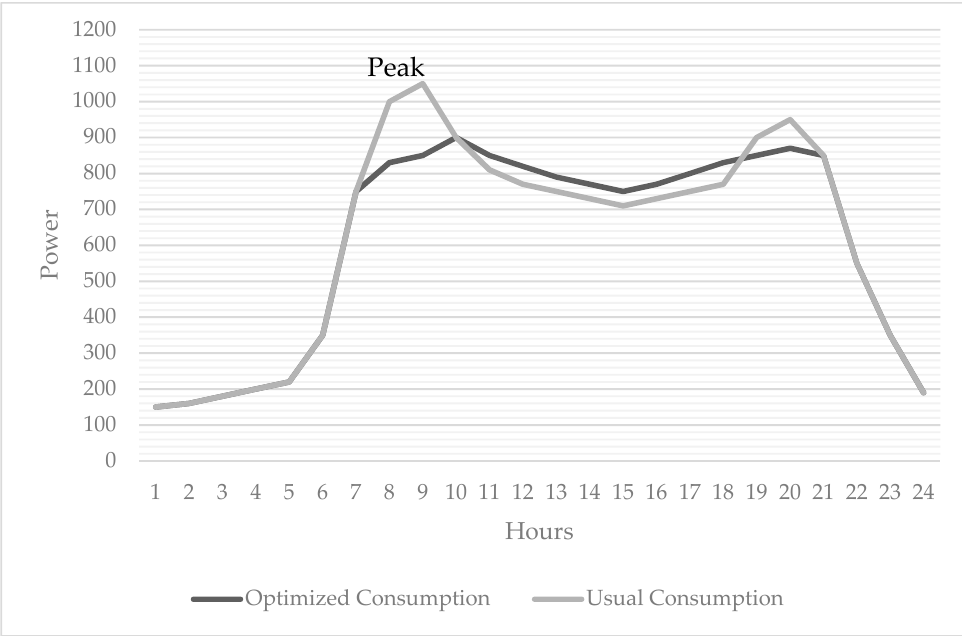
Figure 8. Example of power consumption in a residential house with management of demand and response in smart grids. Table 9. Members, resources and trades of the trading platform.